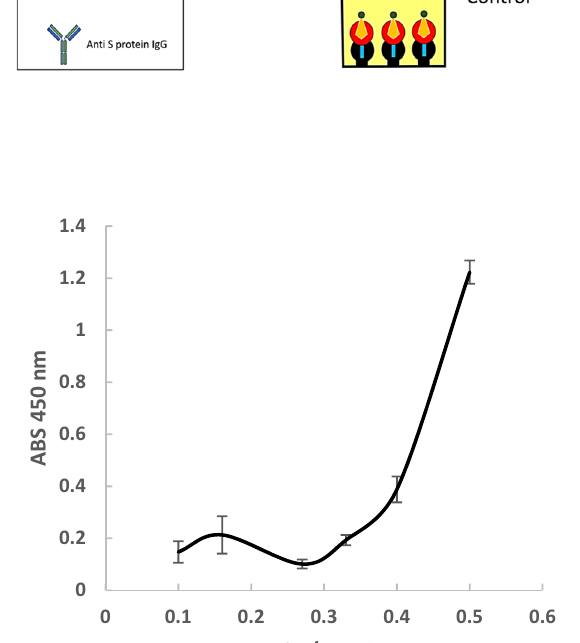
image with different filters: (i) confocal differential interference contrast image of the ENC membrane, (ii) AF488 confocal images of fluorescent clumps of S protein and (iii) overlay of DIC and AF488 images showing the fluorescent clumps of S protein on the ENC membrane.